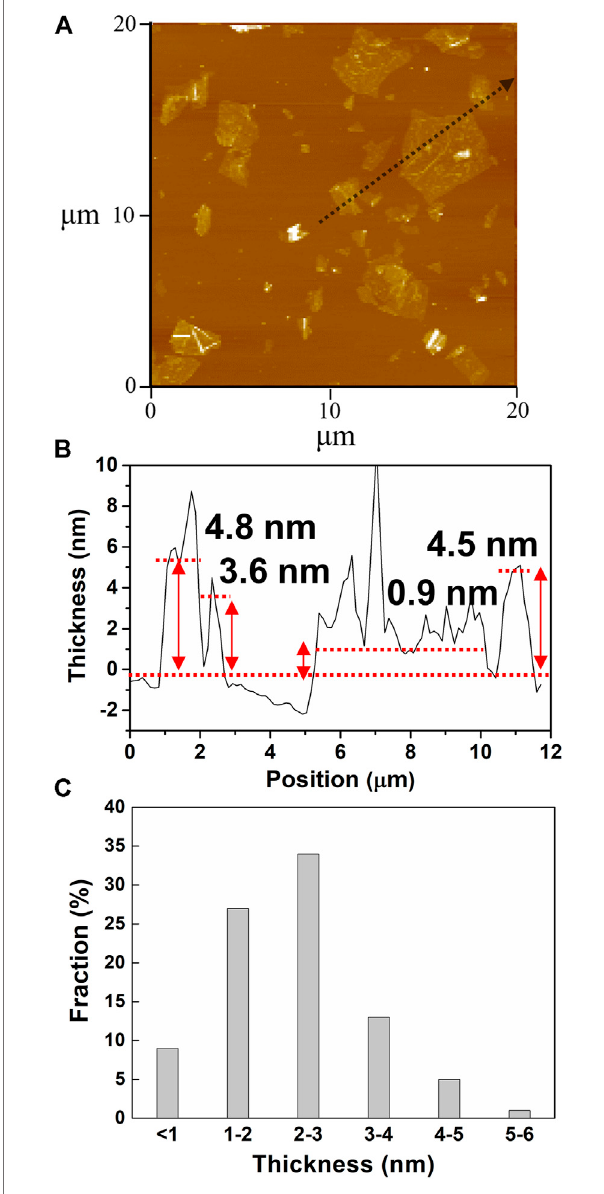
FIGURE 5 | (A) AFM image of the graphene sheets prepared with pH buffer at an initial pH value of 11. (B) Height pro fi le of a line scan about the black arrow in Figure 5A . (C) Histogram of thickness measurements of 100 graphene sheets.